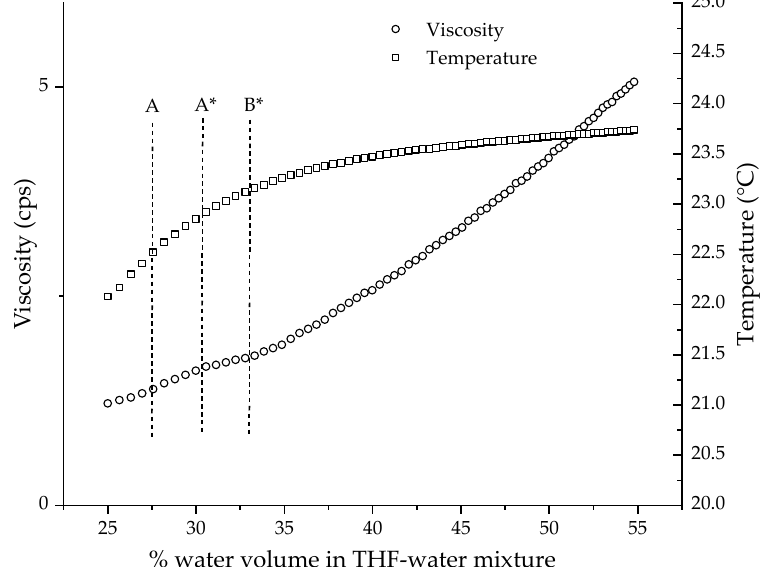
Figure 9. Viscosity against time for THF/water mixture of 75/25 v / v composition with addition of water at different levels (A, A*, B*) on tuning fork shown in Figure 10.